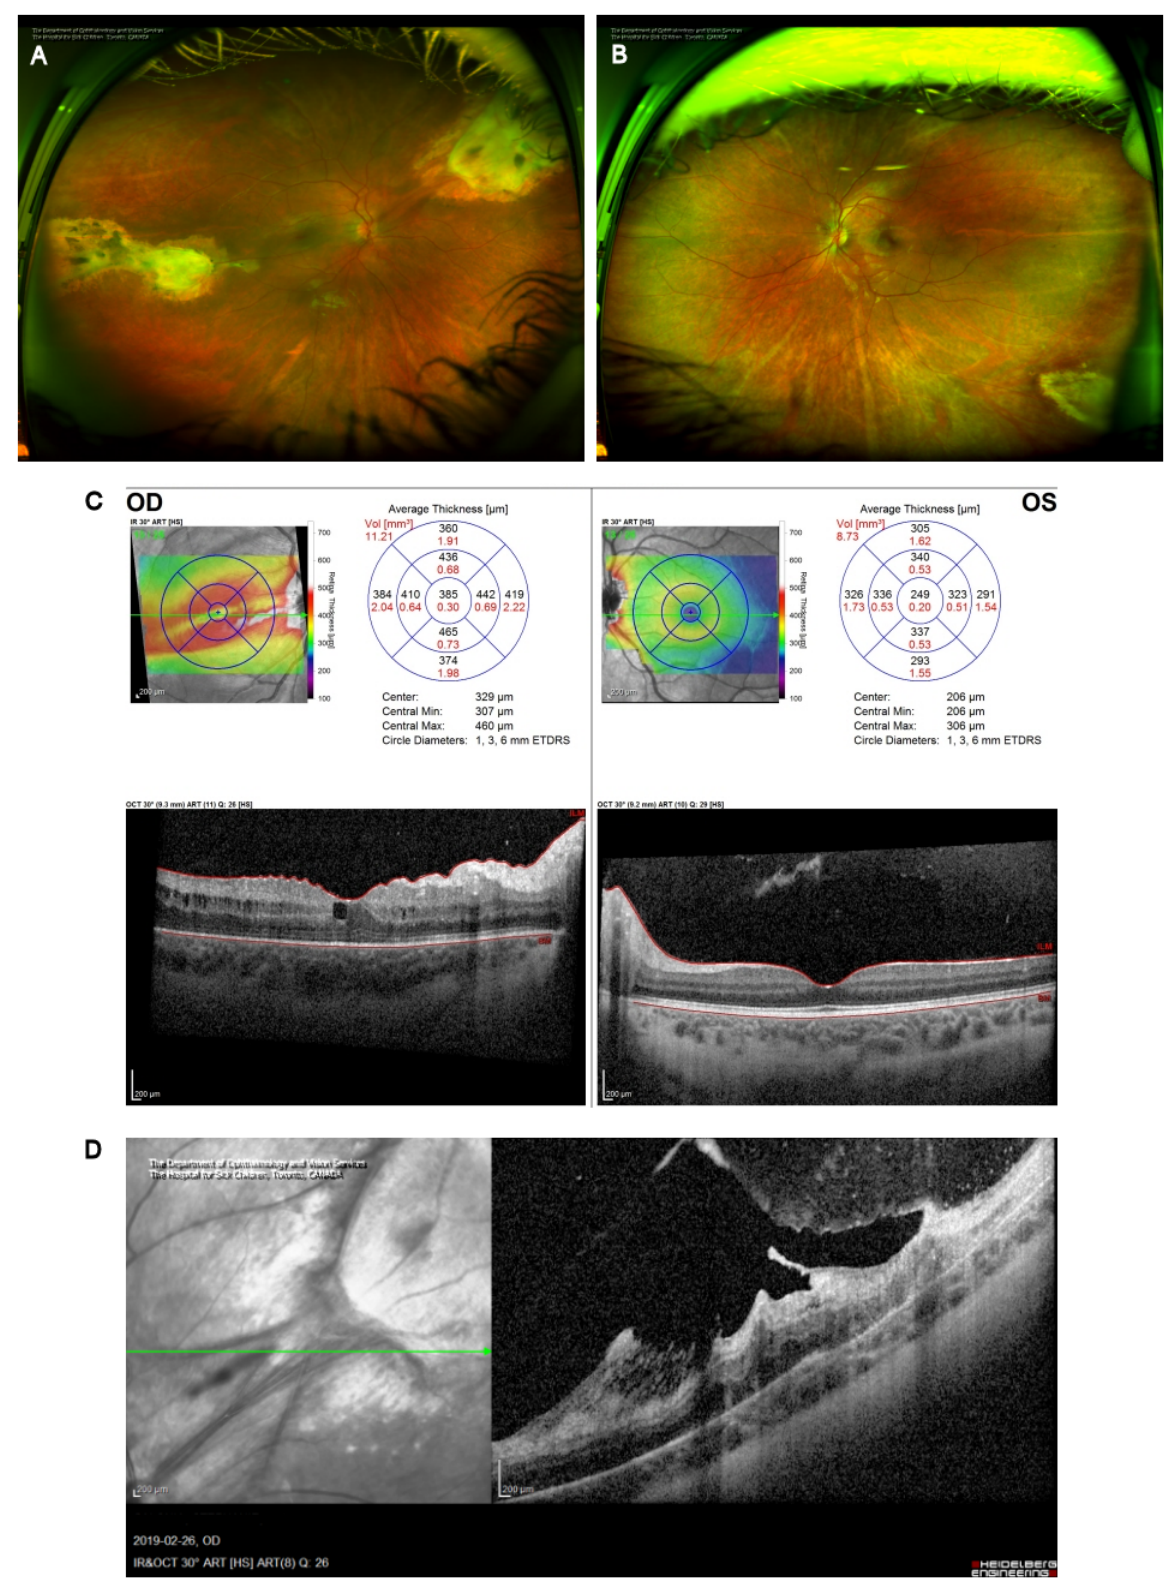
Figure 4: Resolution and scarring. (A) Optos ultra-widefield photography of the right eye and (B) left eye demonstrating the residual retinochoroidal scars in both eyes following successful treatment of toxoplasmosis. (C) OCT analysis demonstrating stable ERM with retail wrinkling and mild CME in the right eye and normal macula of the left eye. (D) OCT analysis of the right eye superonasal scar demonstrates a significant ERM with thickening and scarring. There is also significant retinochoridal atrophy with overlying fibrosis of the